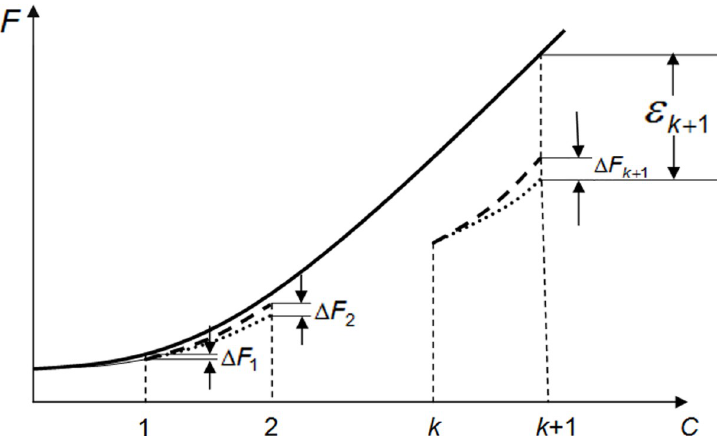
Fig 2. The relationship between the cumulative error and error in each step. In the plot, a solid line represents theoretical curve of amplified product ( F ) with E � 1 ; a dashed line represents theoretical curve of amplified product c C with E � 1 ; a dotted line represents the obtained curve of amplified product with E < 1 . Δ F 1 and Δ F 2 were the C C differences between real measurements and theoretical values after the first and second cycles, respectively. ε k þ 1 represents the cumulative error starting from cycle 0 to cycle k+